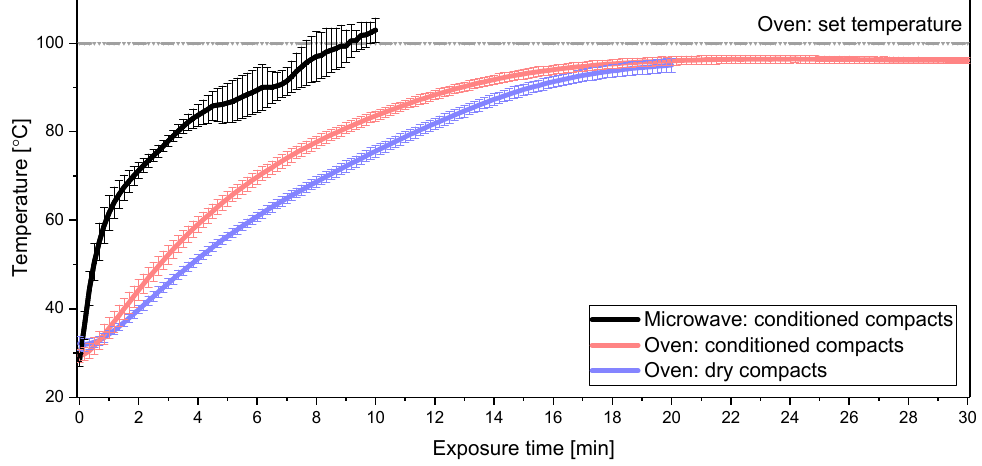
Figure 2. Comparison of the temperature profiles obtained during microwaving of conditioned compacts (black) (see Hempel et al. (2020) [9]) and during convection heating for conditioned (red) and dry (blue) compacts; dotted line (grey) indicates the set oven temperature; temperature (°C) plotted against the exposure time (min); data represents mean ± SD ( n = 3).